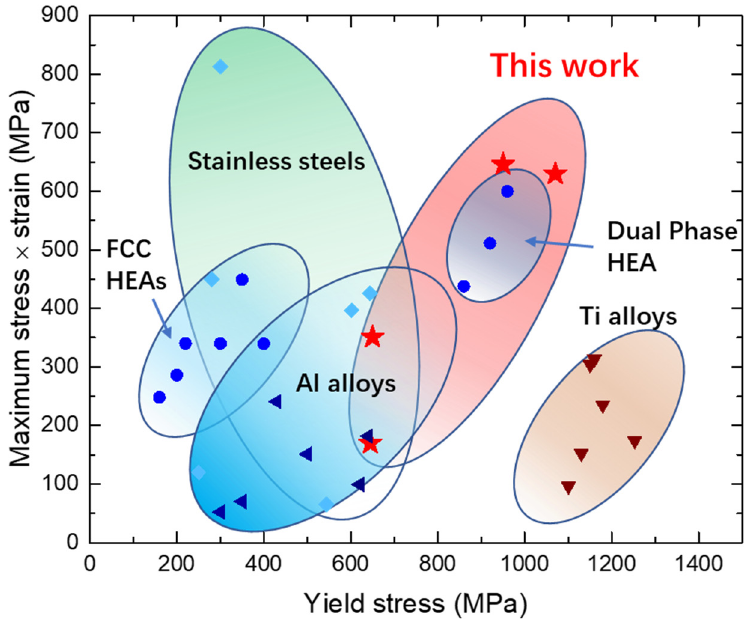
Figure 9. Comparison of dynamic mechanical properties of As-SLM HEA, other FCC HEAs [34–36], dual phase HEAs [37], Al alloys [38–40], Ti alloys [41,42] and stainless steels [43,44].